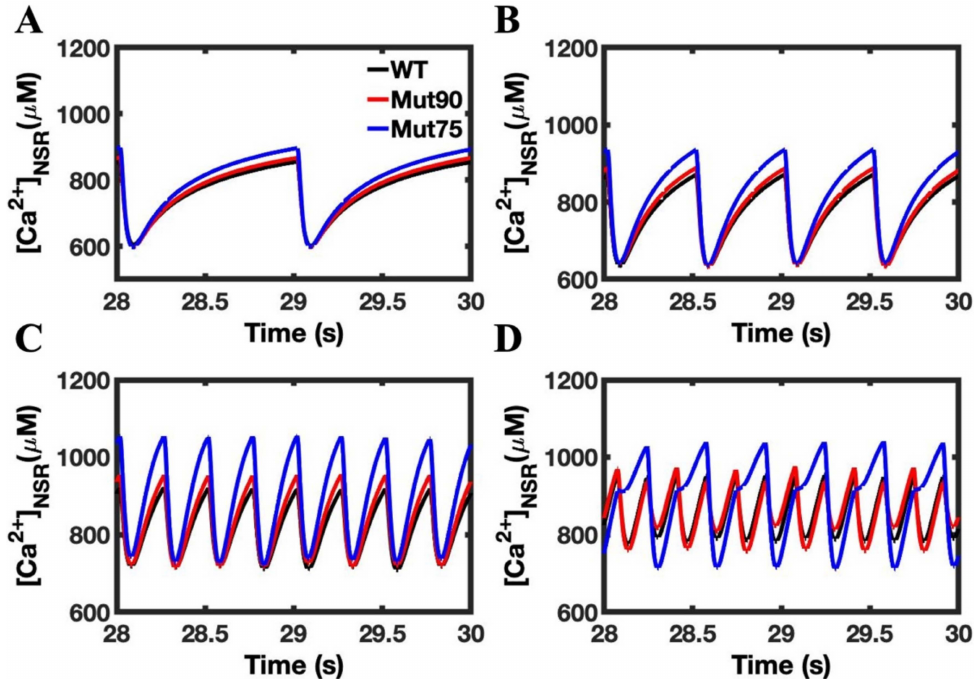
Figure 5. Calcium concentration in the NSR in cardiac myocytes: ( A ) 1 Hz pacing, ( B ) 2 Hz pacing, ( C ) 4 Hz pacing, ( D ) 6 Hz pacing. The mutant simulations CDI (75% of transition rate—blue and 90% of transition rate—red) of the cardiac myocyte show an increase in calcium loading in the SR compared to wild type (black). Shown are representative simulations out of six repeated simulations with different random number seed values in each case. The different simulation traces for each condition overlap at steady-state